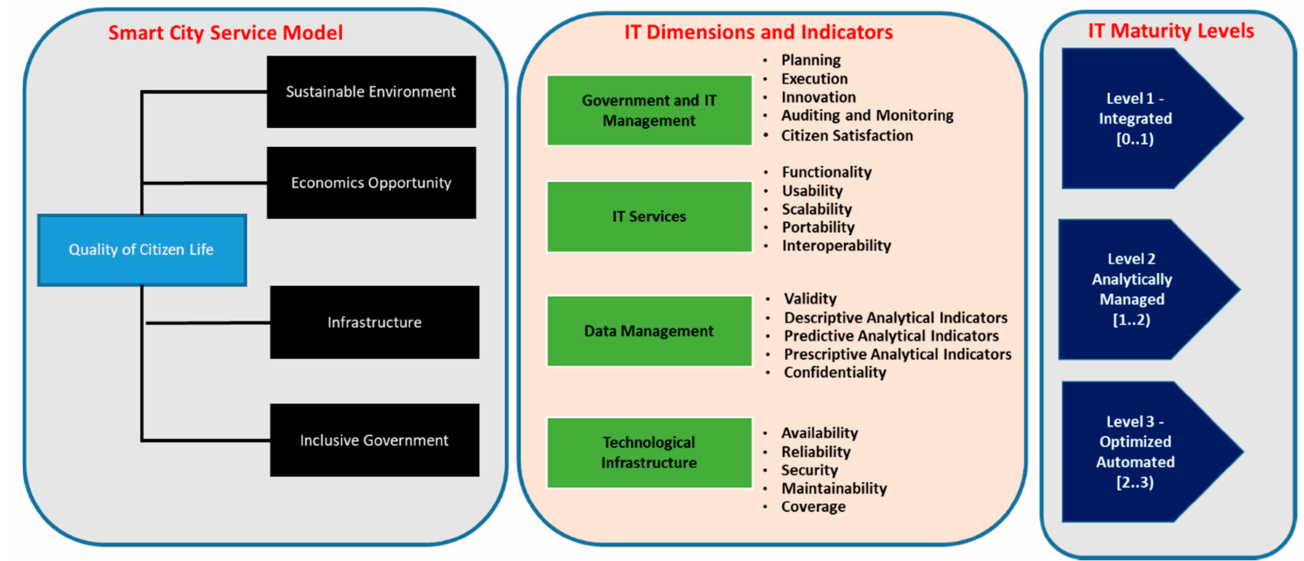
Figure 1. Proposed IT maturity framework for smart city